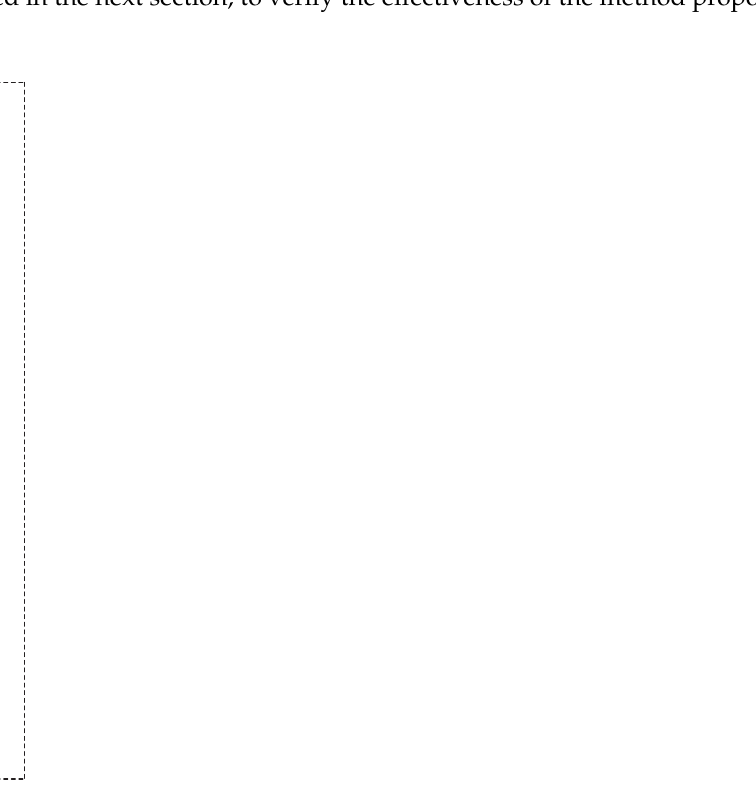
Figure 8. Structural diagram of the modified backbone